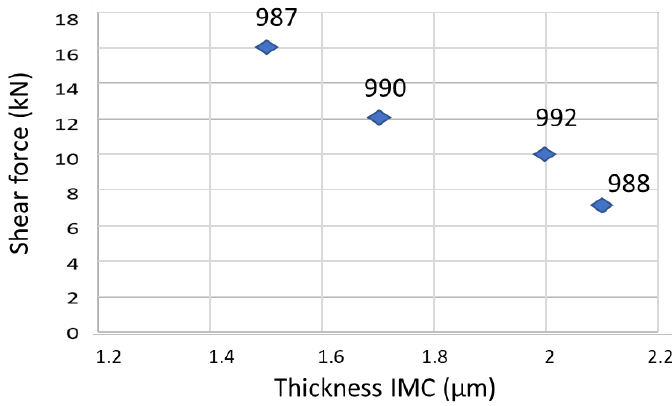
Figure 11. Shear force versus intermetallic thickness.